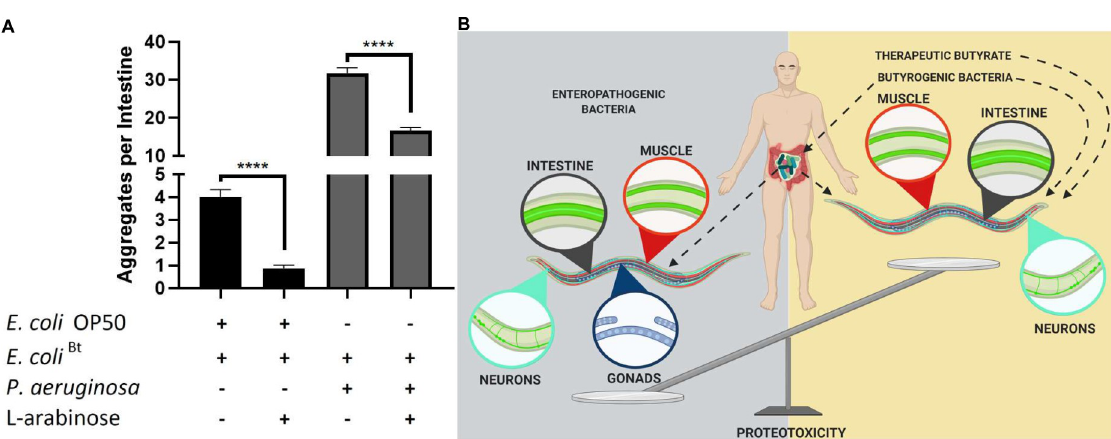
Fig 10. Co-colonization of E . coli Bt suppresses P . aeruginosa -mediated enhancement of polyQ aggregation. A) The effect of butyrogenic bacteria ( E . coli Bt ) on the aggregation of intestinal polyQ44 (AM738) in worms co-colonized with E . coli OP50 or P . aeruginosa in the presence and absence of 3% L-arabinose. Data are represented as the average number of aggregates per intestine. Each bar is an average of three independent experiments with a total of 100 animals. Error bars represent SEM. Statistical significance between each pair was calculated using Student’s t-test ( ���� p < 0.0001). B) Model figure. Enteropathogenic bacteria disrupt proteostasis across C . elegans tissues, including intestine, muscle, neurons, and gonads. The bacteria-mediated proteotoxicity is alleviated by butyrate and butyrogenic